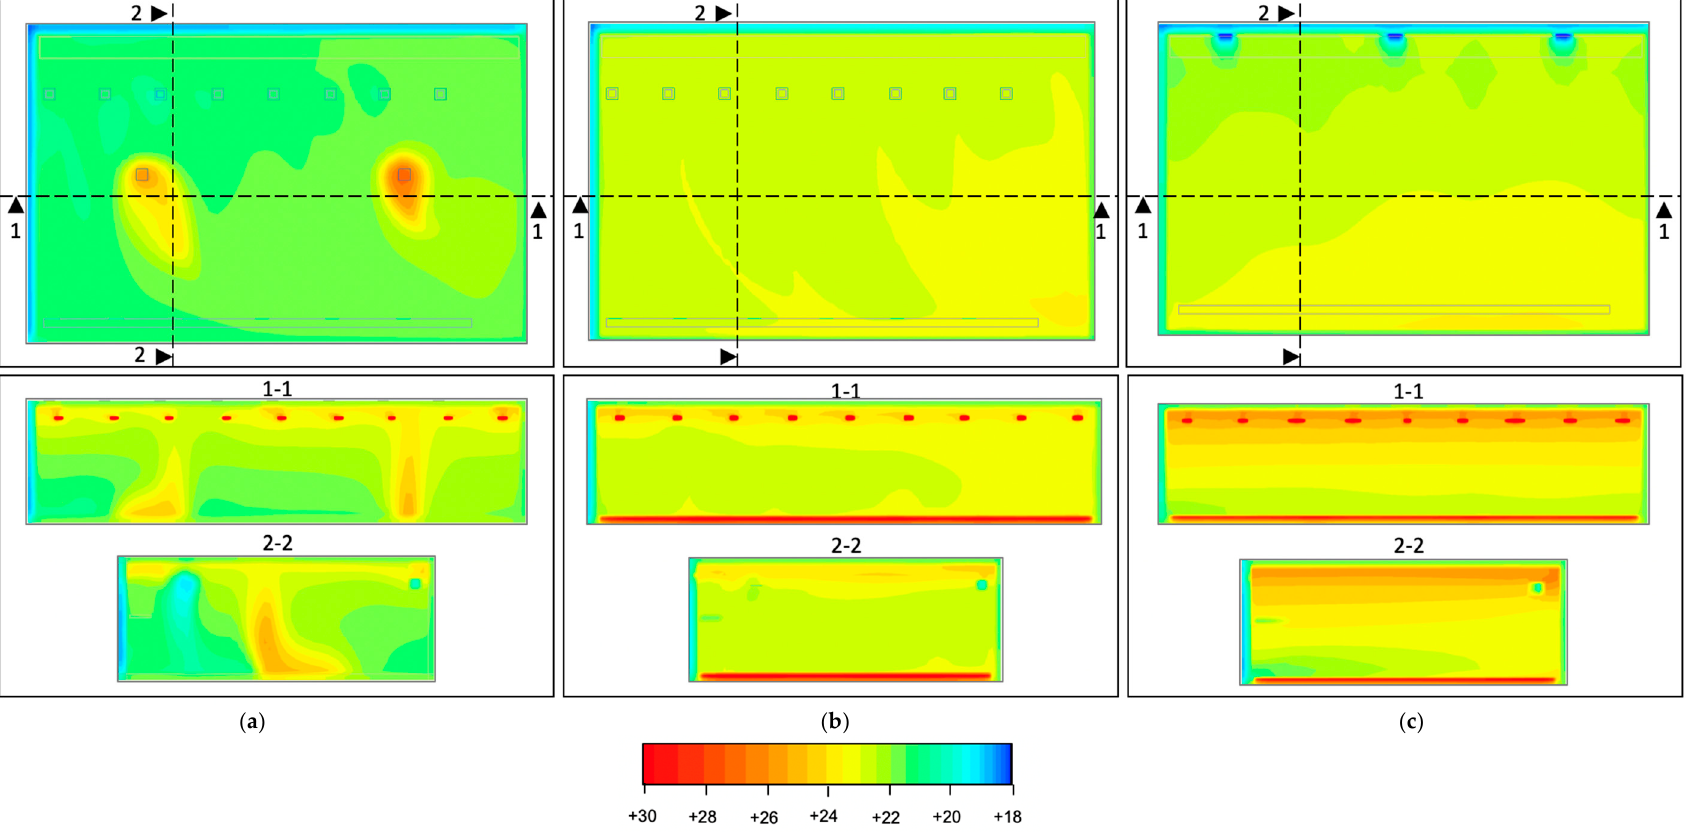
Figure 7. Temperature distribution for the cases with warm air heating combined with mechanical mixing ventilation ( a ), underfloor heating combined with mechanical mixing ventilation ( b ), and underfloor heating combined with mechanical displacement ventilation ( c ).